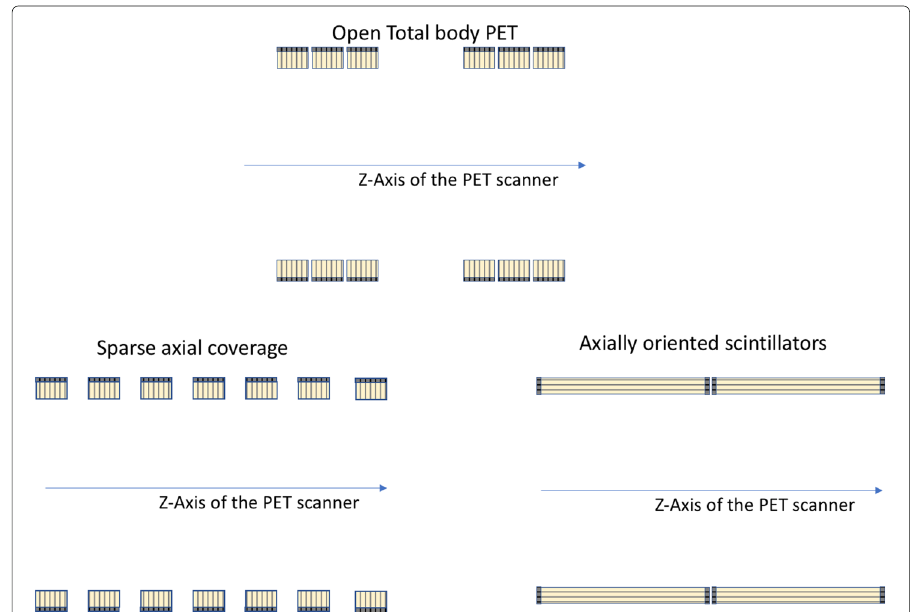
Fig. 13 Proposed cost-effective designs for total body PET systems